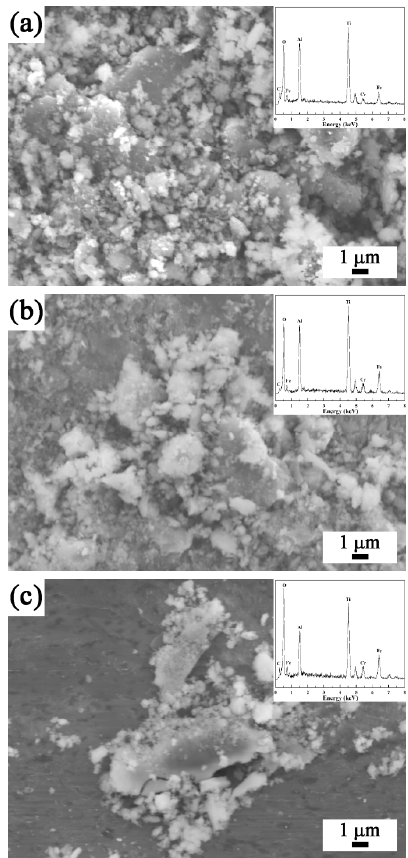
Fig. 5 SEM micrographs and EDS analysis of debris on the worn surface of tailored Ti 3 AlC 2 ceramic tested under the load of 5 N: (a) TTS sample, (b) TSS-1 sample, and (c) TSS-2